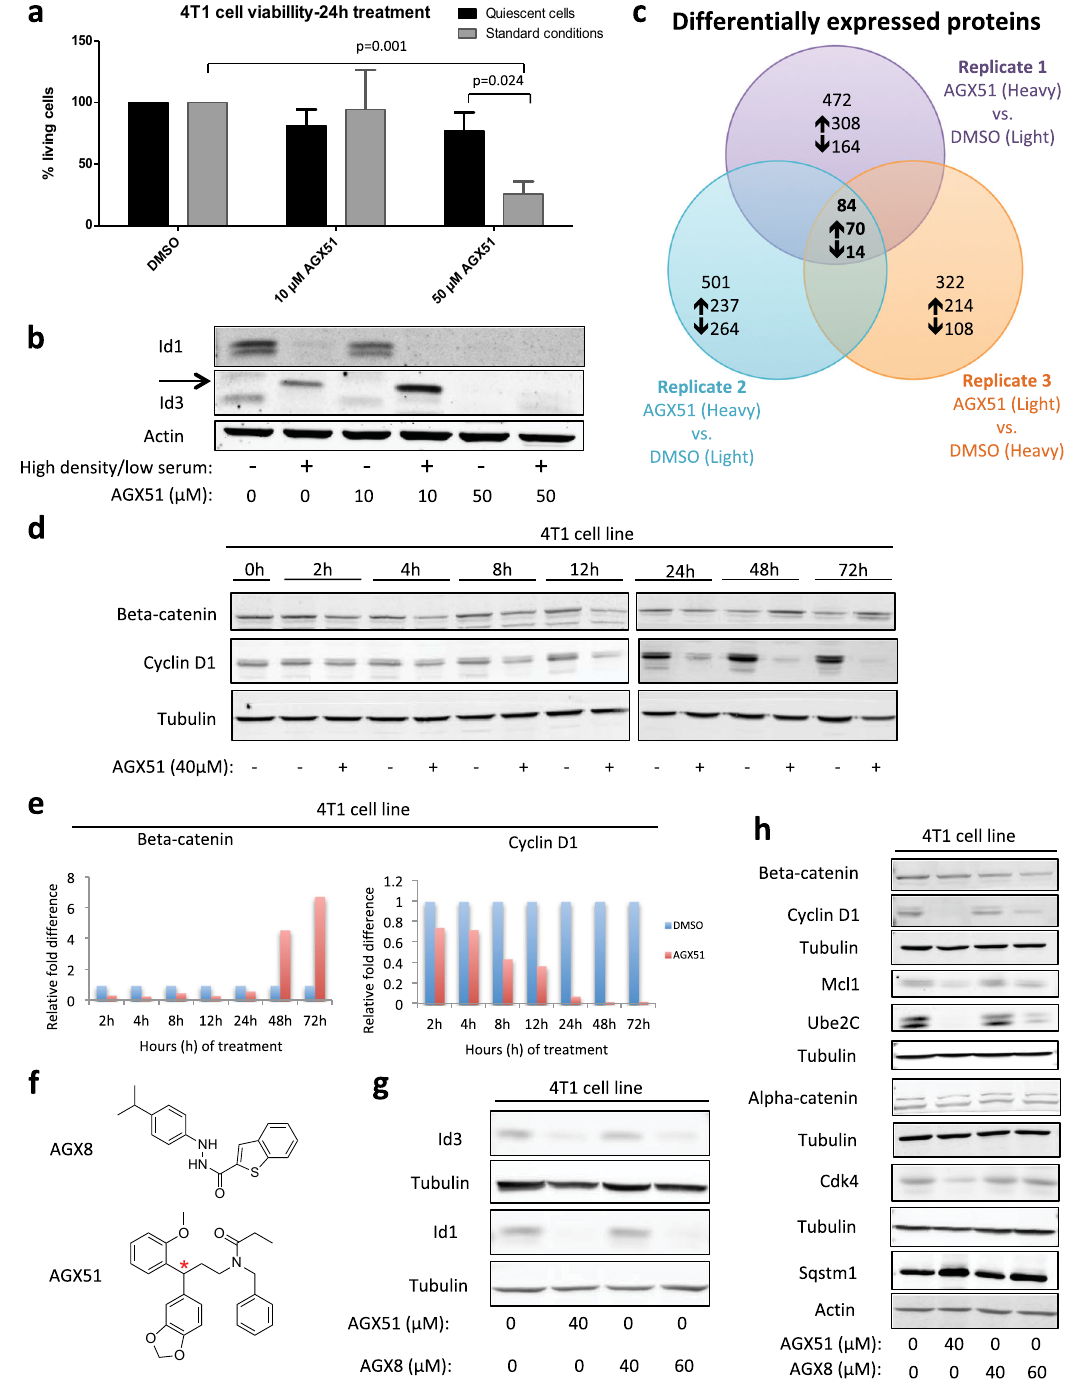
Fig. 4 Assessing the effect of AGX51 on quiescent cells and the whole proteome. a 4T1 cells were treated with AGX51 (10 or 50 µM), when they were cultured under standard conditions (standard density, standard serum (10%)) or under quiescence-inducing conditions (high density, low serum (1%)). Following 24 h of AGX51 treatment, cell numbers were determined by cell counting and trypan blue exclusion. Means are plotted with error bars showing SD of four technical replicates. b Western blot for ID1 and ID3 on whole-cell lysates from 4T1 cells presented in ( a ). Actin serves as the protein loading control. Arrow indicates non-speci fi c band. c Venn diagram of differentially expressed proteins, as identi fi ed by mass spectrometry, from three replicates of SILAC-4T1 cells treated with 40 µM AGX51 for 4 h. d Western blot for Beta-catenin and Cyclin D1 on whole-cell lysates from 4T1 cells treated with 40 µM AGX51 for 0 – 72 h. e Quanti fi cation of western blot shown in ( d ). f Structures of AGX8 and AGX51 (red asterisk indicating chiral center). g Western blot for ID3 and ID1 on whole-cell lysates from 4T1 cells treated with AGX51 and AGX8 at the indicated concentrations. h Western blot for the indicated proteins on whole-cell lysates from 4T1 cells treated with AGX51 and AGX8 at the indicated concentrations. Quanti fi cation of western blot bands shown in ( g ) and ( h ) are in Supplementary Fig. 7. See also Supplementary Figs. 4 –